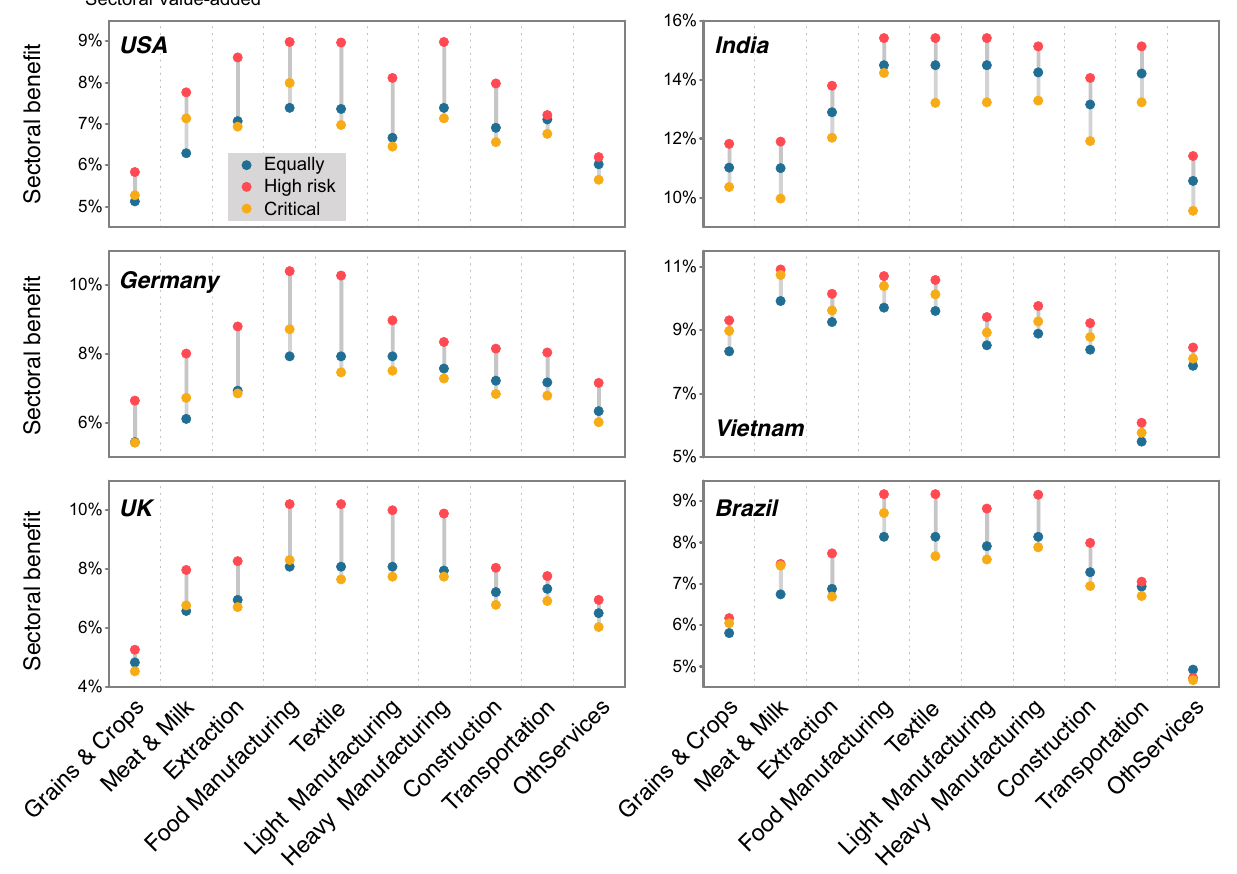
Fig. 5 | Sectoral bene fi ts under three scenarios with different vaccination priorities of industrial sectors. The x-axis represents ten industrial sectors (see SupplementaryTable4forsectoralinformation),andthey-axisrepresentsthetotal economicbene fi tof eachindustrialsector(expressed asapercentageof thevalue- added of the corresponding industrial sector). Color represents different vacci- nation scenarios: blue, any available dose will be equally allocated from the outset totheworkingpopulationsacrossalleconomicsectors(Equally);red,anyavailable